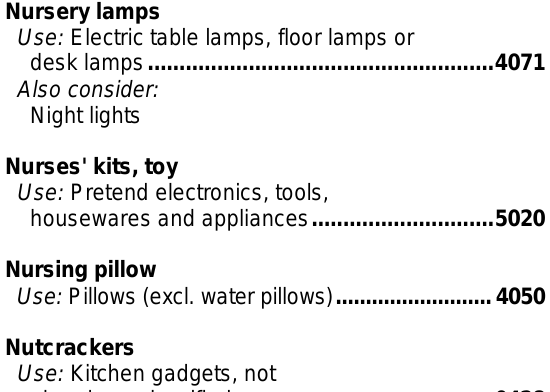
Nursery lamps Use: Electric table lamps, floor lamps